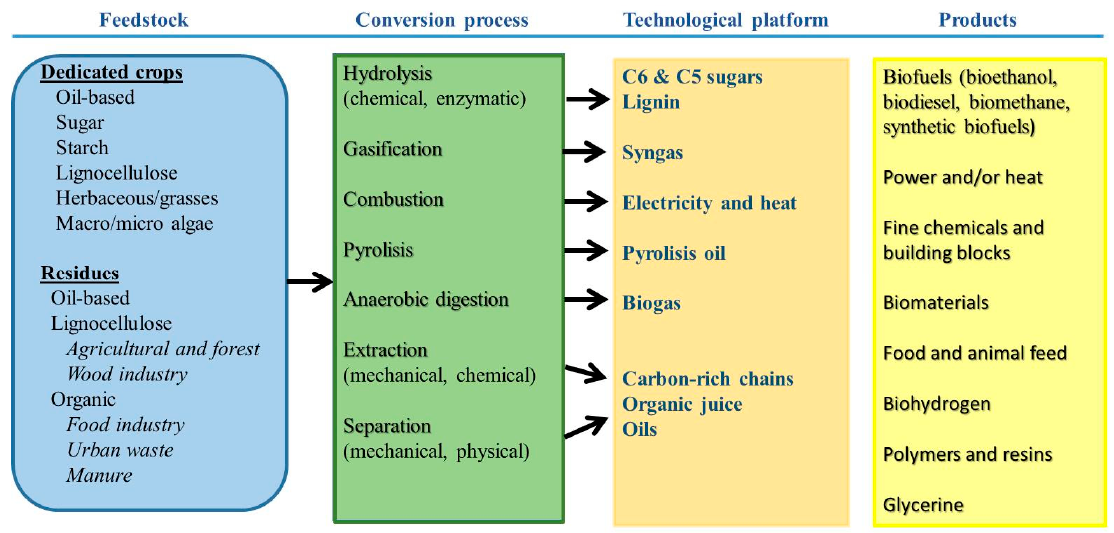
Figure 2. Main elements that make up biorefinery systems. Data from [160].